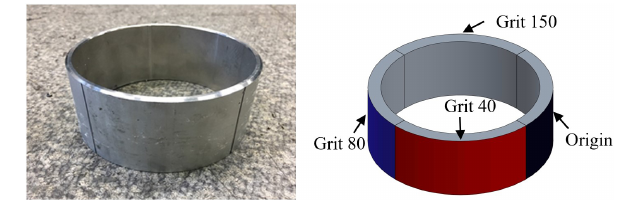
Figure 4. Four-section test specimen.